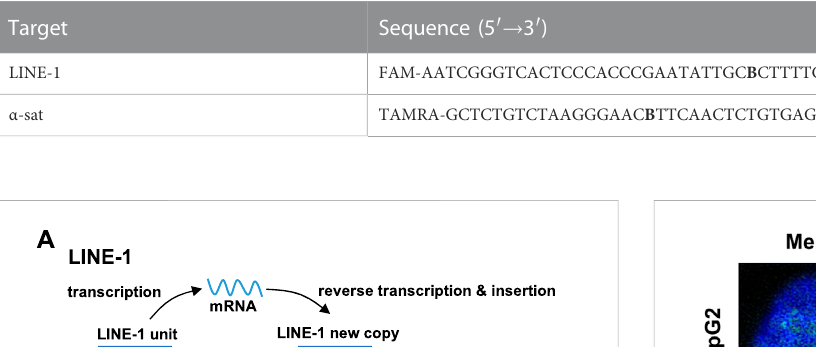
TABLE 1 Sequences of ICON probes for LINE-1 and α -sat. The bold capital letter B indicates the bipyridine-attached adenine.